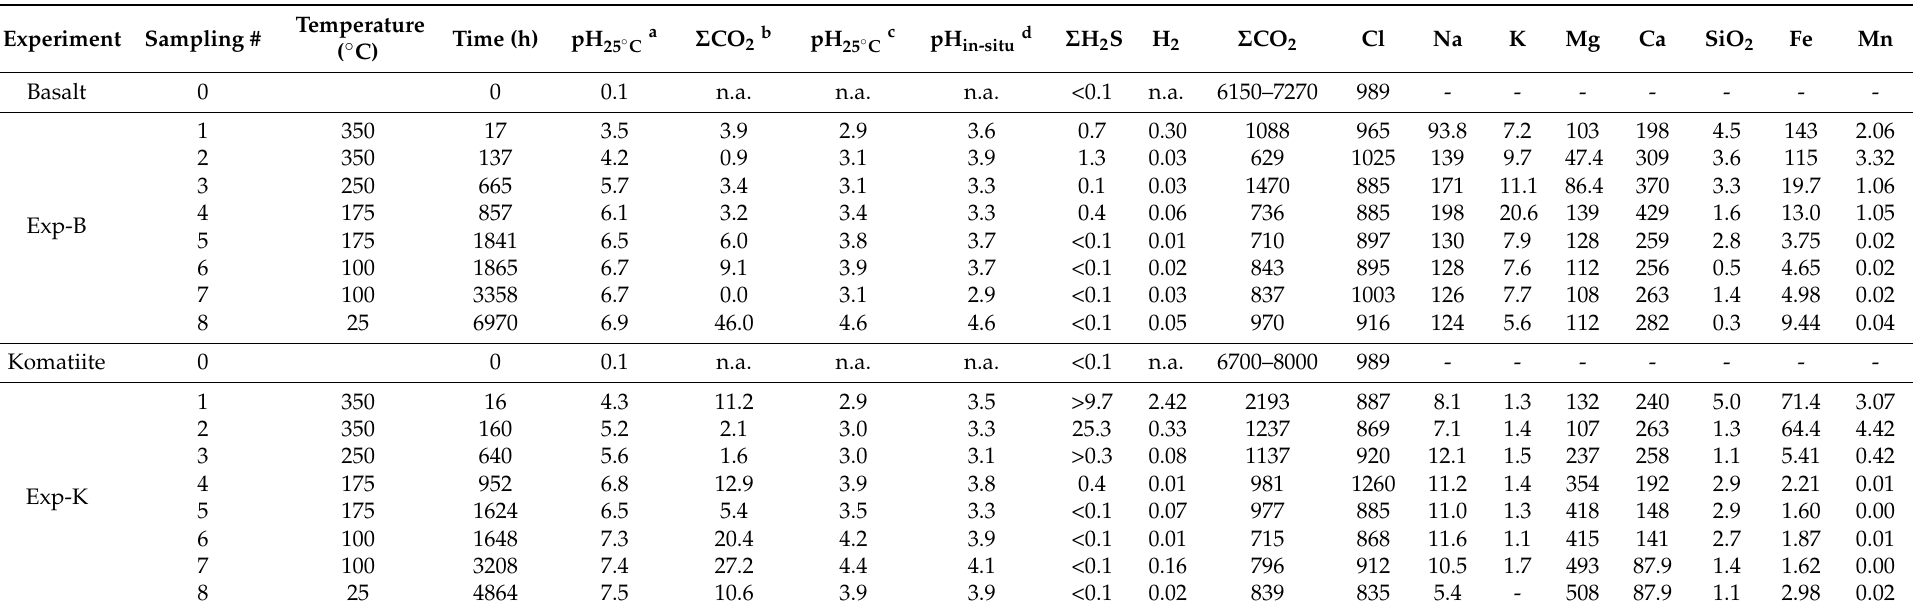
Table 4. Compositions of the sampled fluids in the experiments